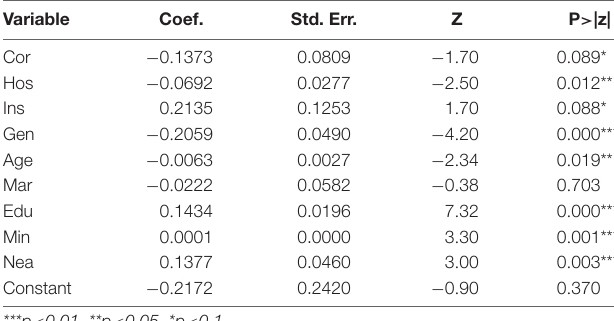
TABLE 4 | Results for robustness test with an alternative model.